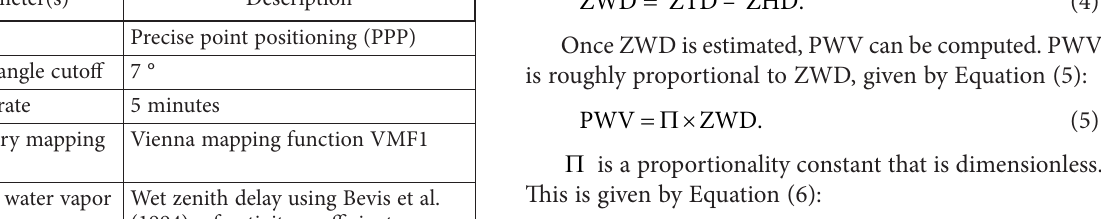
Table 1. Parameters used in computing PWV by NGL Parameter(s)